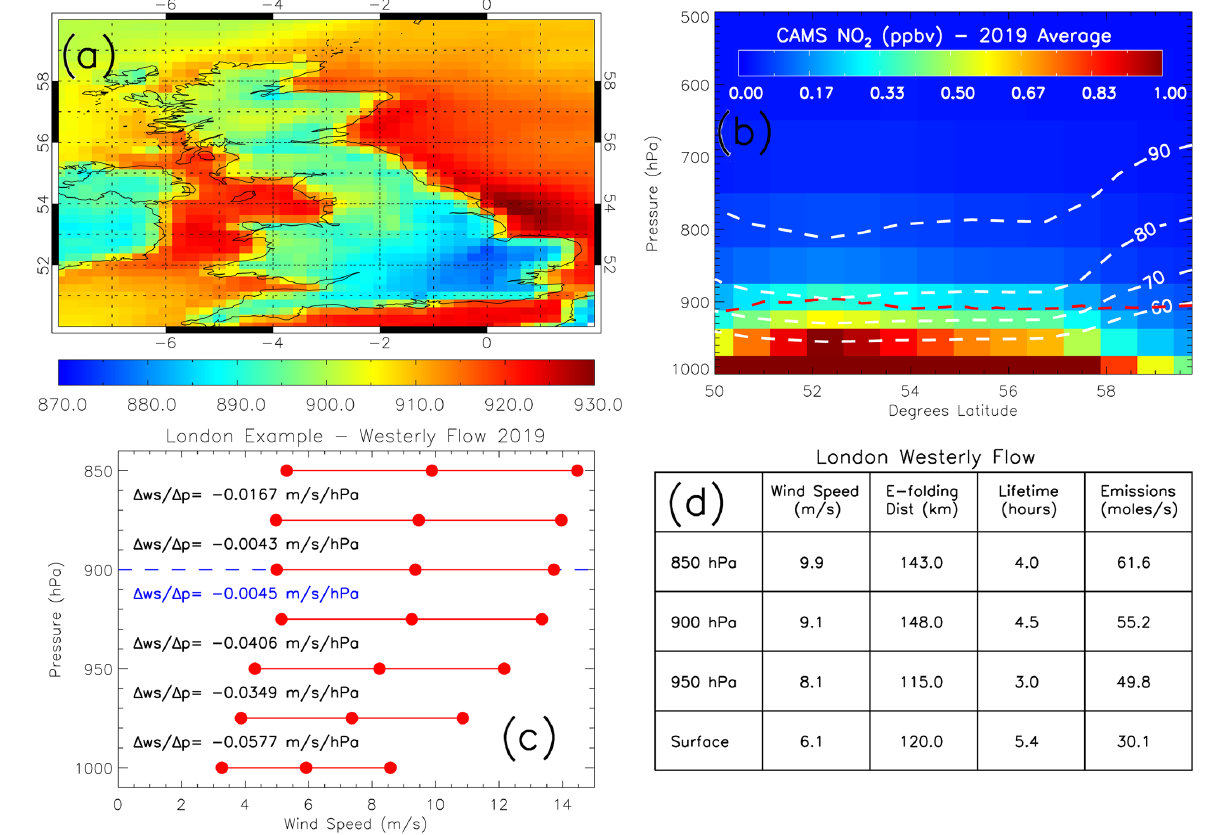
Figure 1. (a) ERA-5 UK boundary layer pressure (hPa) sampled at 13:00LT (to coincide with the TROPOMI overpass time) and averaged for 2019. (b) CAMS reanalysis zonal (8.0 ◦ W–2.0 ◦ E) average latitude–pressure NO 2 (ppbv) cross section over the UK between the surface and 500hPa. White dashed lines represent the percentage of the surface-500hPa NO 2 loading between the surface and the respective pressure levels. The red dashed line represents the zonal average boundary layer pressure (hPa). (c) Average (surface to pressure level) wind speed (ms − 1 ), ± the standard deviation, profile over London under westerly flow (determined from the ERA-5 u -wind and v -wind components at each pressure level). (cid:49)ws/(cid:49)p is the wind speed gradient between pressure levels. The blue text indicates the first small step change in the gradient indicative of reduced flow turbulence and a suitable surface-altitude range to average the winds speeds over. (d) The table shows the impact on the NO x emission parameters when using different altitudes over which to average the wind